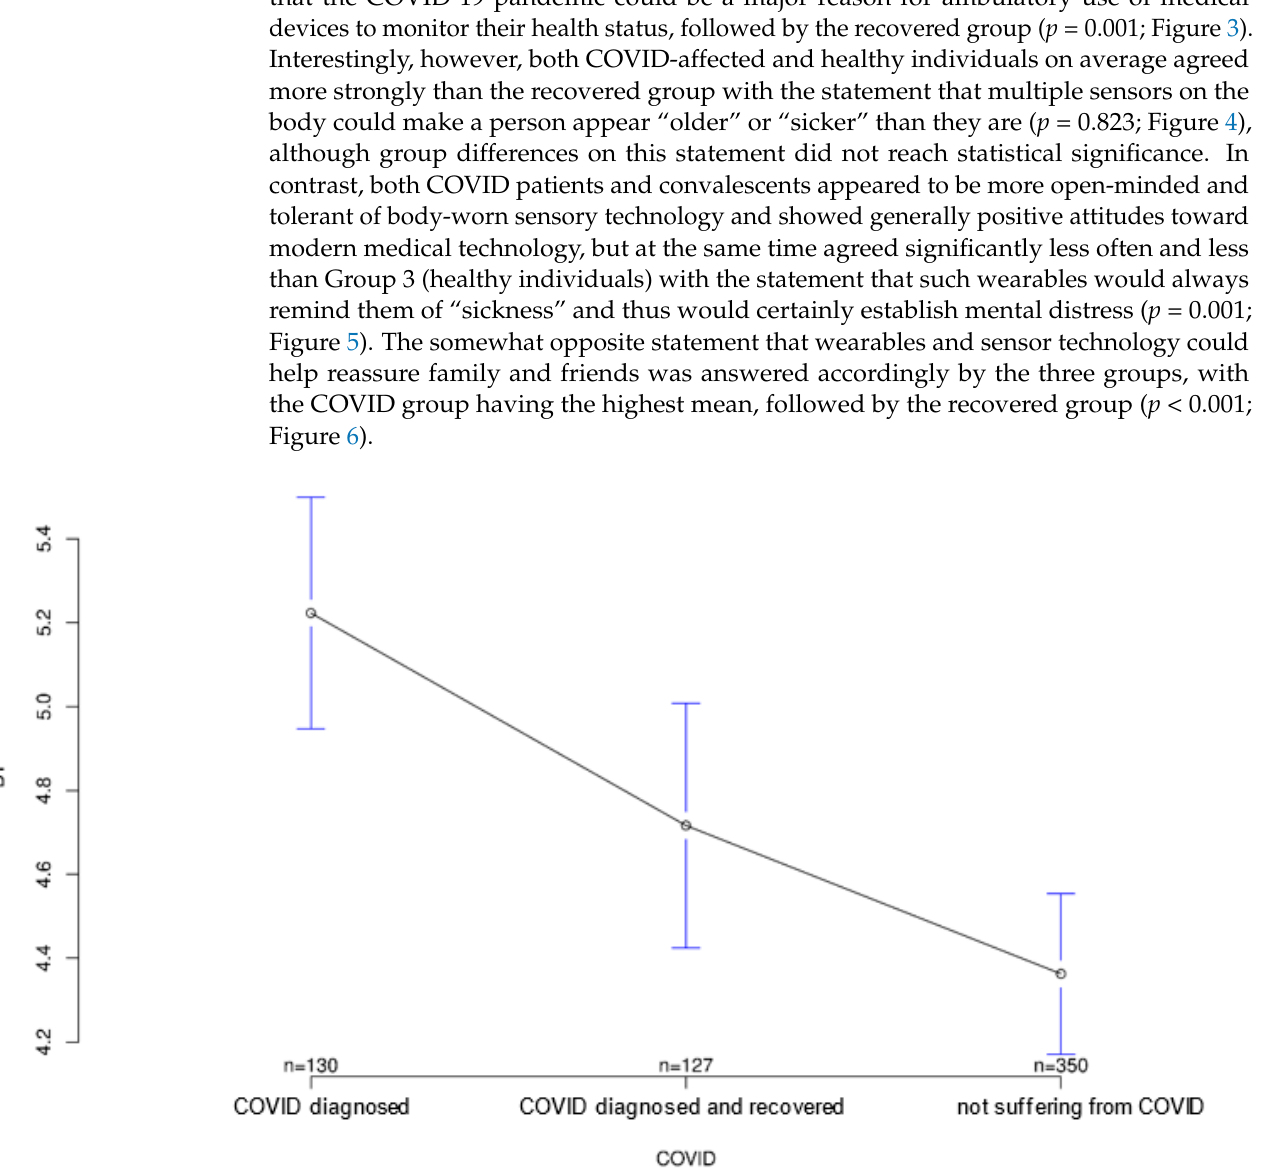
Figure 3. Average agreement with statement 1 of the COVID-specific questionnaire: “The Covid-19 pandemic is a reason for outpatient use of medical devices to monitor health conditions.” The y -axis shows the mean result of participants choice on the Likert scale.